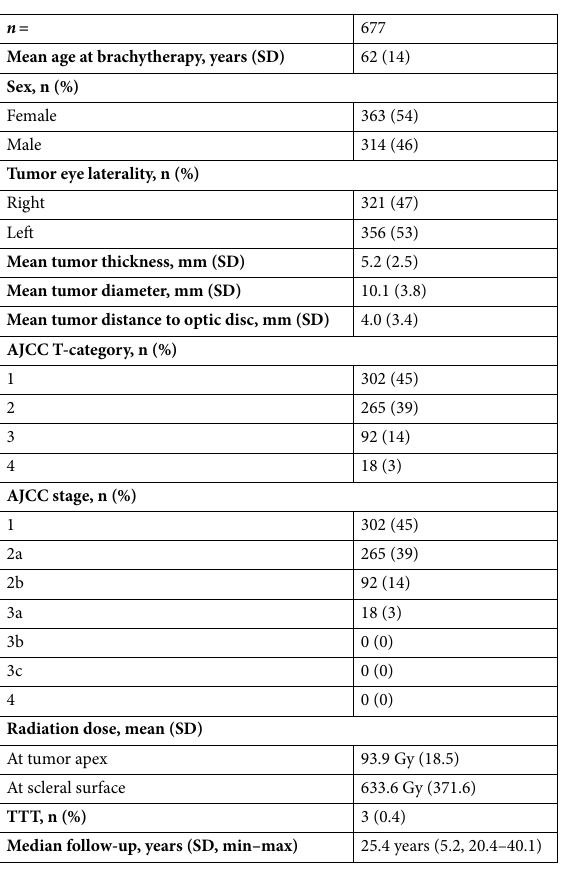
Table 1. Characteristics of patients and tumors included in this study. SD, standard deviation; AJCC, American Joint Committee on Cancer; Gy, Gray; TTT, transpupillary thermotherapy given prior to or at the time of brachytherapy.